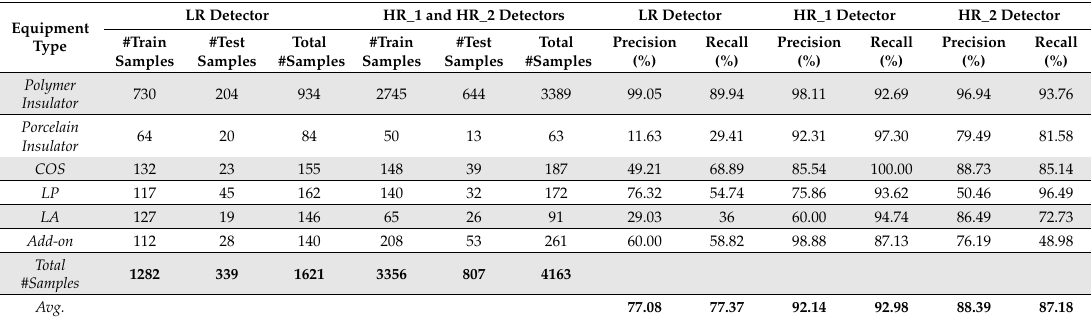
Table 2. Summary of performances of the proposed LR, HR_1 and HR_2